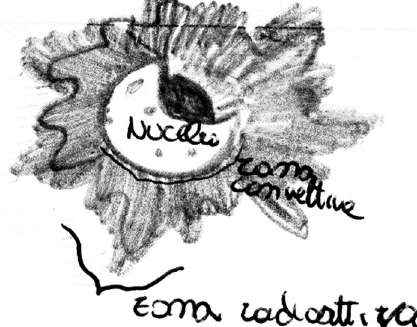
FIG. 5. More precise student sketch of a star ’ s internal and external structure. Translation of Italian labels, from top to bottom: core, convective zone, radiative